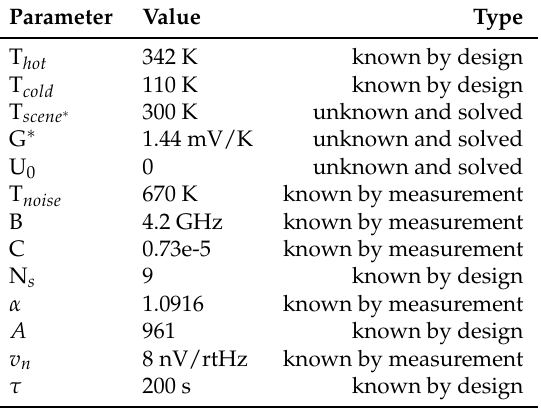
Table 1. Parameters used in the simulation. The type refers to whether or not the parameter is known to the simulator. the brightness temperatures are given at the calibration plane of the